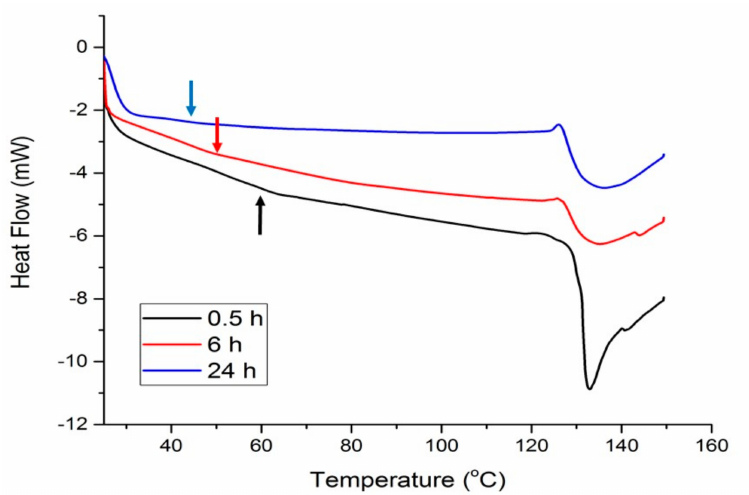
Figure 4. DSC curves for gelatin samples with 20% Glyceline after di ff erent setting times.